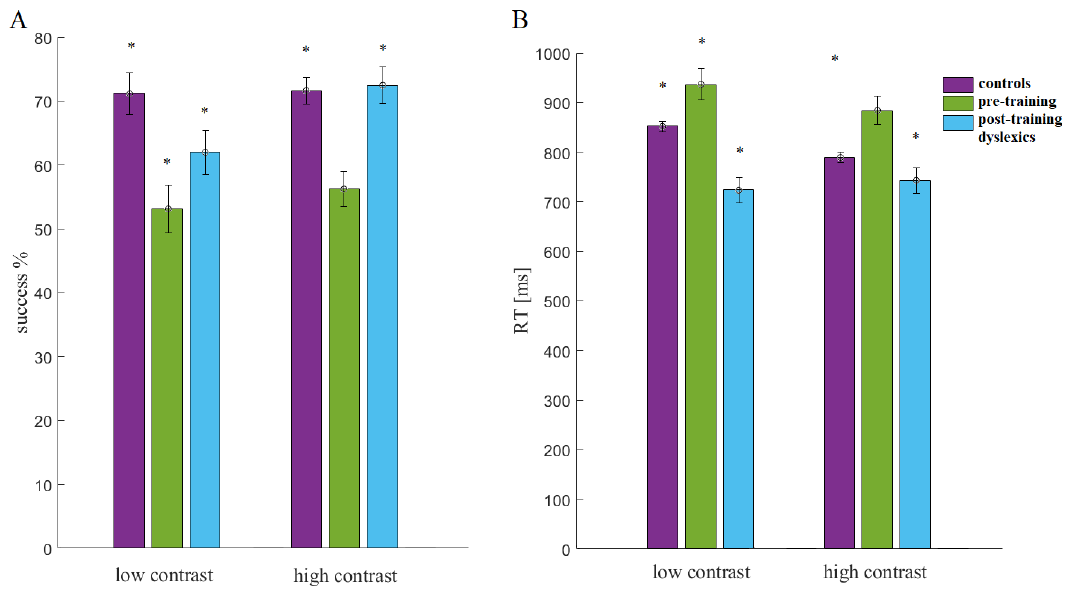
Figure 6. Statistical comparisons (Kruskal – Wallis test, p < 0.05; marked with stars): ( A ) success (%) and ( B ) reaction time (RT).